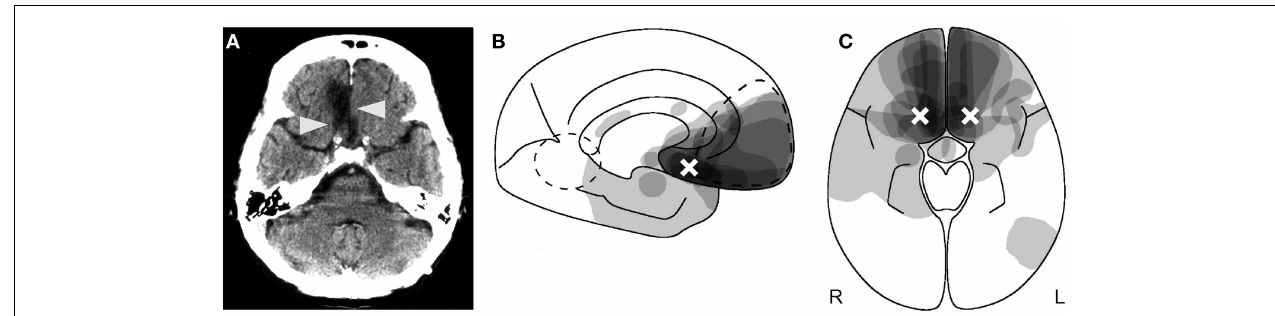
shades of gray, maximal lesion overlap was in the posterior medial orbitofrontal area.The white crosses indicate the area of peak activity in healthy subjects who performed a similar task as the one on which the reality-confusing patients failed. (B,C) Reproduced from Schnider (2008), with